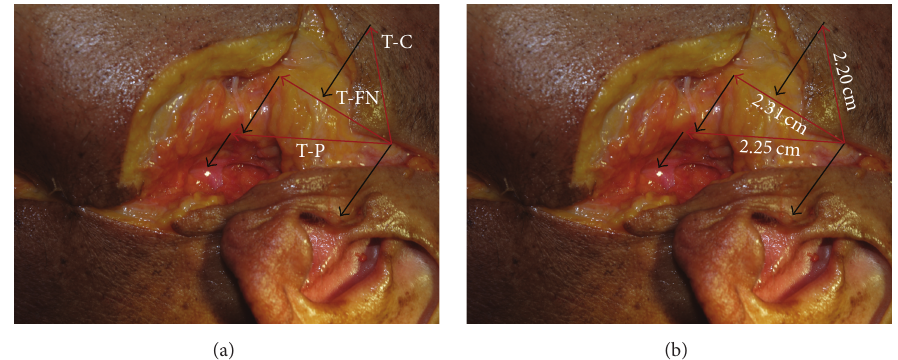
Figure 1: Illustrated in photo are the relationships of the temporozygomatic (upper) division of the facial nerve (FN) to the tragus (T), lateral pole of condyle (C), and pes anserinus (P).